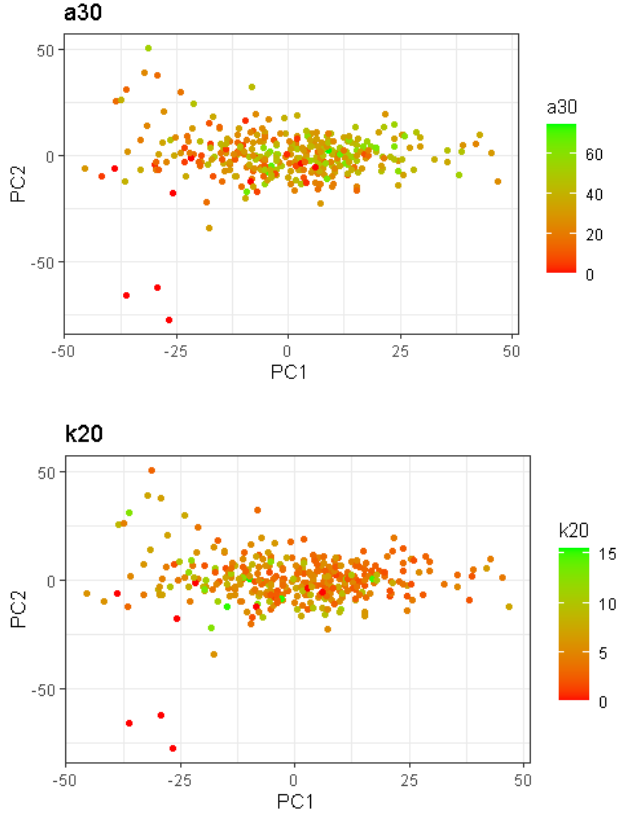
Figure 4. First and second principal components of the dataset, with each point representing a spectrum, and the points coloured according to the values of a30 and k20.